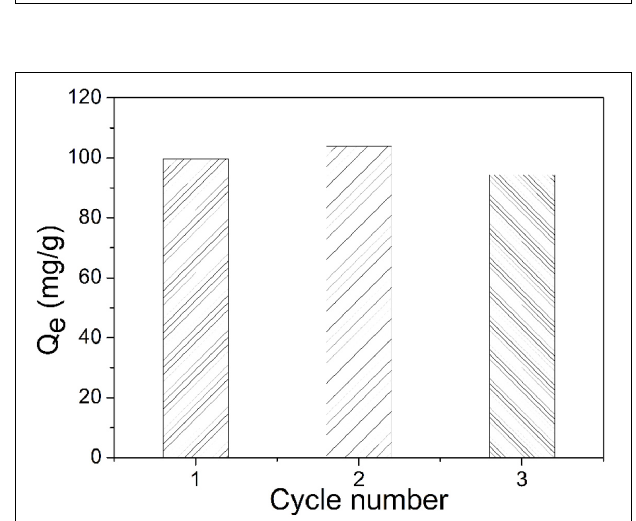
FIGURE 10 | The reusability of TiO 2 /Ti adsorbents in the target solution (temperature 298 K, pH 5.0, amount of TiO 2 /Ti 0.025 g, mixing time 60 min, and C 0 = 200 mg L − 1 ).